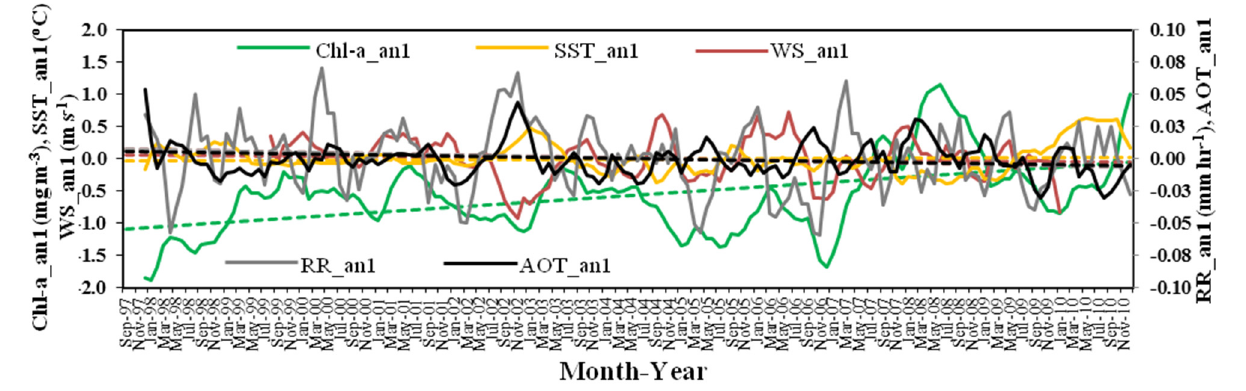
Figure 14. Four-month moving averages of SeaWiFS chlorophyll- a concentration anomaly (Chl- a _an1), SeaWiFS aerosol optical thickness anomaly (AOT_an1), TRMM rain rate anomaly (RR_an1), AVHRR/MODIS sea surface temperature anomaly (SST_an1) and QuikScat wind speed anomaly (WS_an1) (seasonality-removed anomalies) in the southern region of the SM during the period of the SeaWiFS full mission. Dashed lines are trend lines derived from linear regressions of variable anomalies versus time (months). The linear regressions for Chl-a_an1, RR_an1, AOT_an1, SST_an1 and WS_an1 are associated with correlation coefficients of 0.43 ( p < 0.0001), 0.07 ( p > 0.3), 0.12 ( p > 0.1), 0.05 ( p > 0.5) and 0.05 ( p > 0.5),